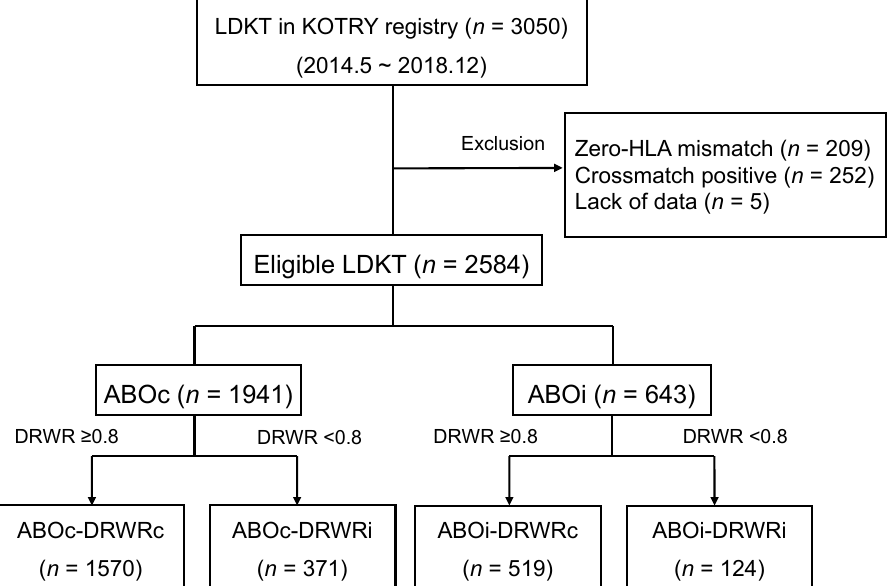
Figure 1. Study population. DRWR, donor-recipient weight ratio; HLA, human leukocyte antigen; LDKT, living donor kidney transplantation.